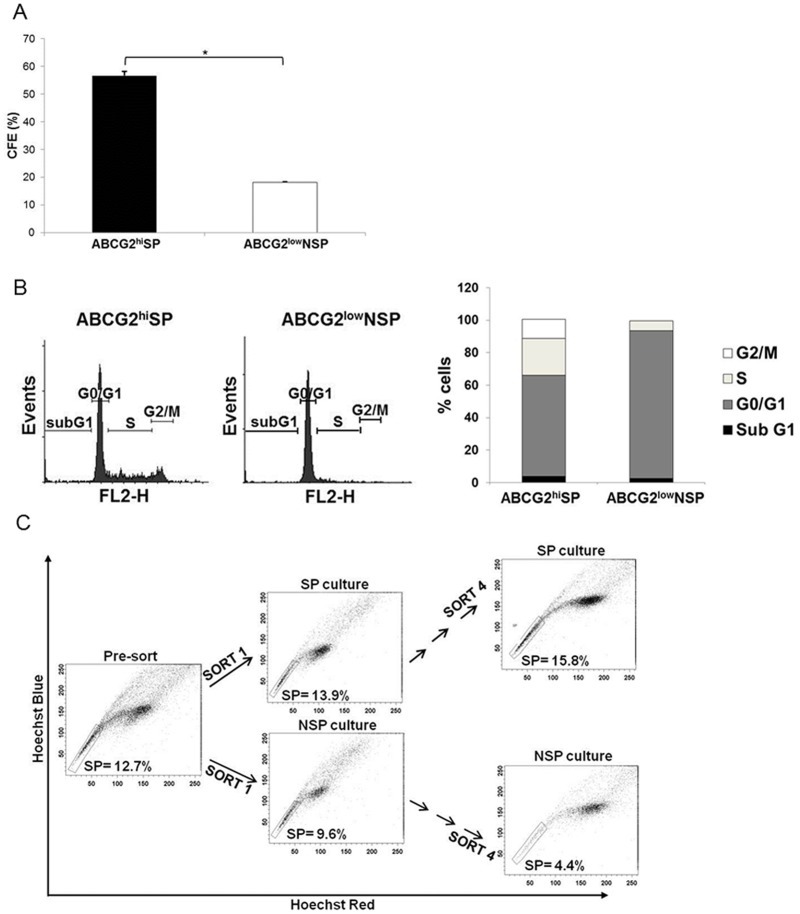
ABCG2hi SP cells have a higher clonogenic ability in comparison to ABCG2low NSP cells.(A) FACS sorted cells were seeded in 6-well plates at a density of 1×102 cells/well and colonies were counted after 2 weeks. Colony forming efficiency (CFE) was calculated as described in Materials and Methods. Data shown are the mean (±SE) of three independent experiments each done in triplicate. *P<0.05 (Student’s two-tailed t-test). (B) Cell cycle profiles of RT112 ABCG2hi SP and ABCG2low NSP cells showing an increase in S-phase in the ABCG2hi SP fraction. (C) Serial selection, sub-culture and cytometric fractioning between RT112 SP and NSP cells. SP and NSP cells sorted from RT112 were cultured for two weeks, restained with Hoechst 33342 dye and reanalysed by flow cytometry. This process was repeated 4 times.